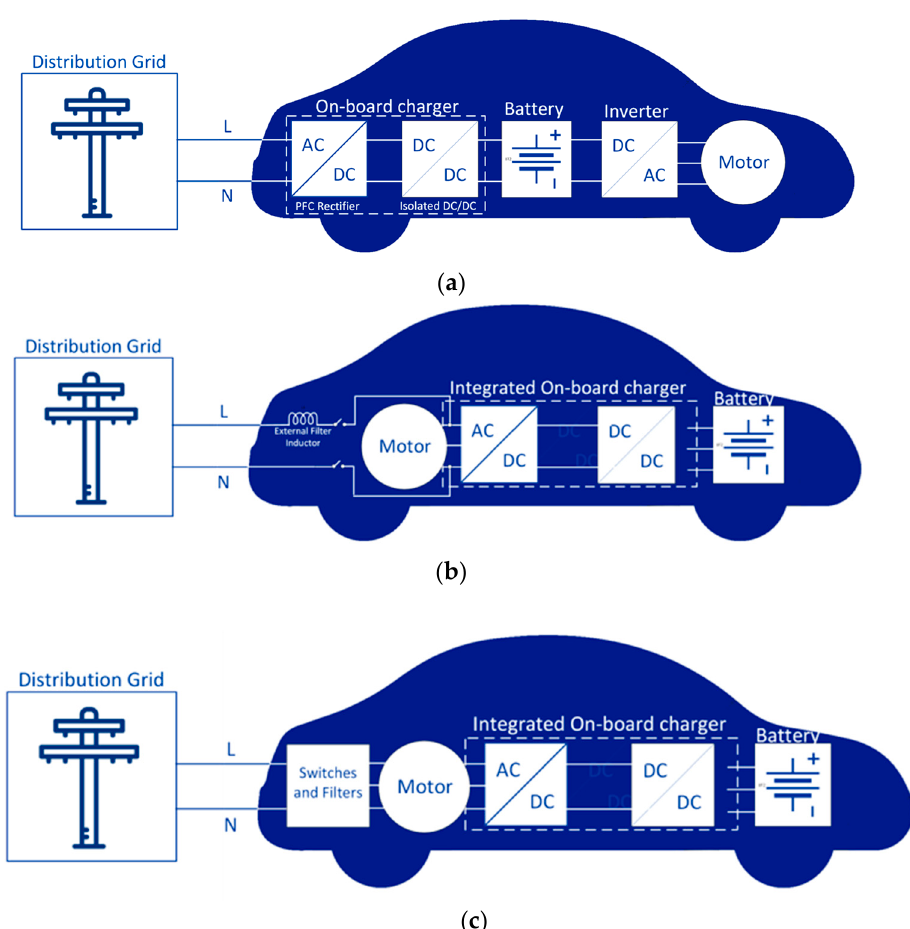
Figure 2. On-board power electronic interfaces for EV Charging. ( a ) Conventional on-board charging system. ( b ) Integrated on-board charger system with external filter inductor for grid. ( c ) Integrated on-board charger system with motor coil as filter inductor for grid.